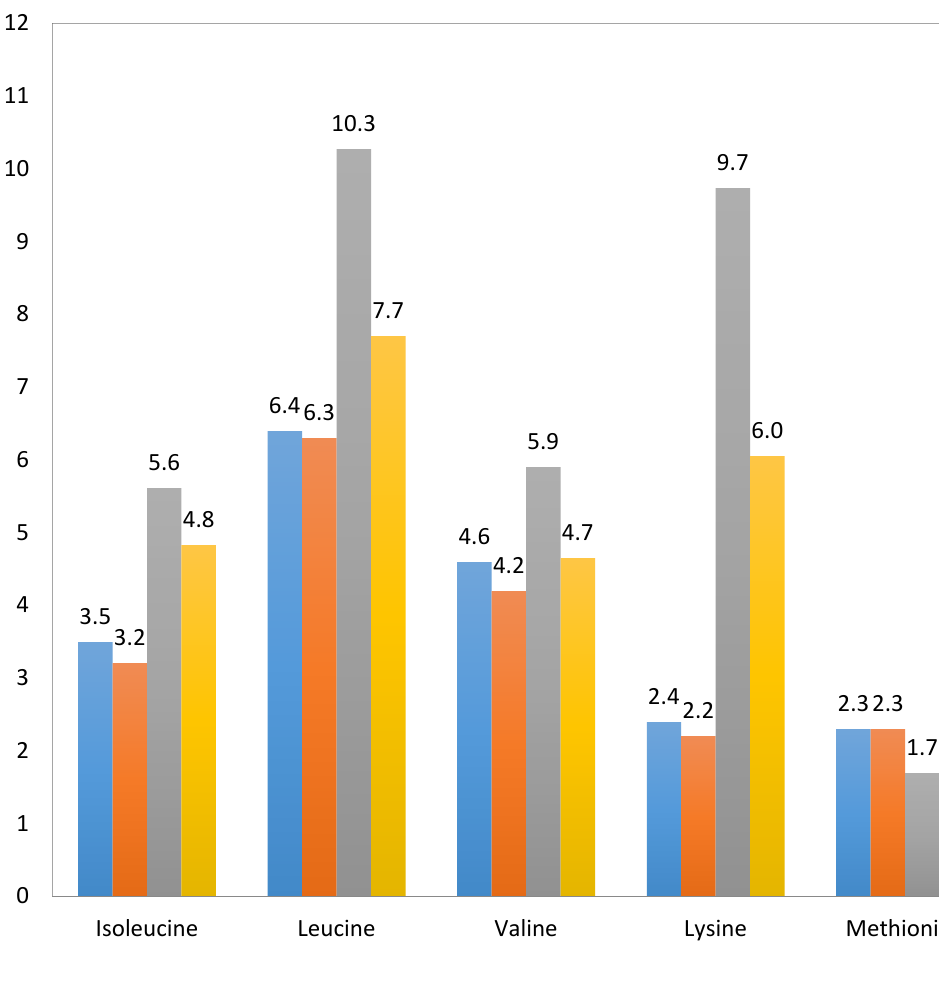
Figure 1. Essential amino acid profiles of Oryzatein-90 organic brown rice batch A and B, soy, and whey protein